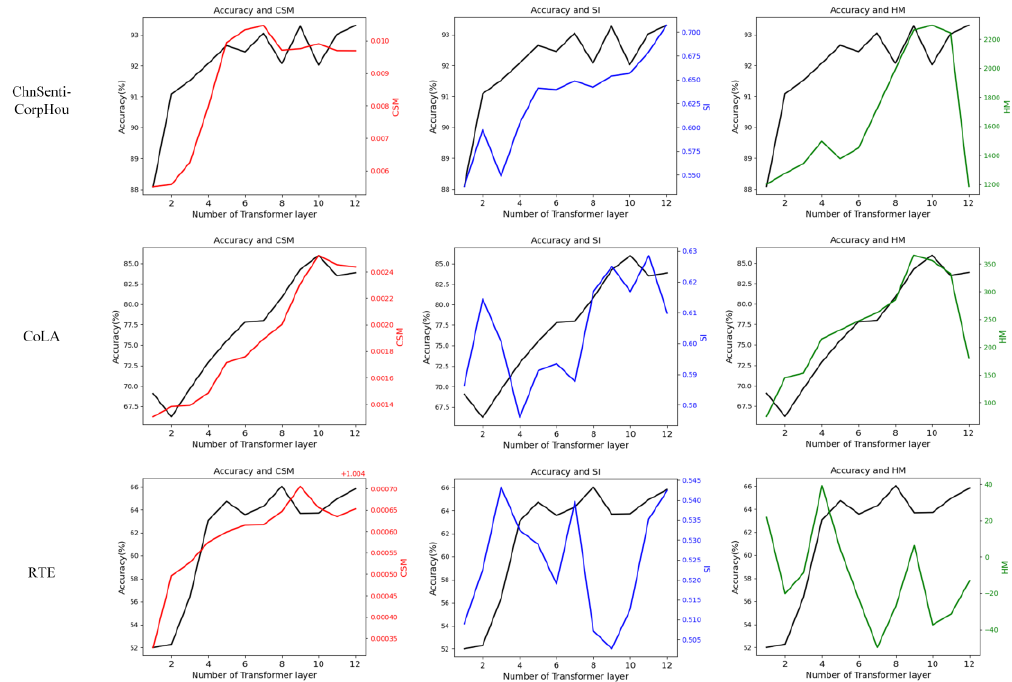
Figure 4. The test accuracy (black) vs. CSM (red), SI (blue) and HM (green) curves on 3 BTC datasets. We juxtapose the separability index and classification accuracy for all 12 Transformer layers. The horizontal axis is the layer index of BERT, the left vertical axis is the classification accuracy and the right vertical axis is the separability index. Each row corresponds to a different dataset, and each column corresponds to a different separability index. Best viewed in color. Table 2. The Pearson’s correlation coefficients between test accuracy and each of the three separa- bility indices.